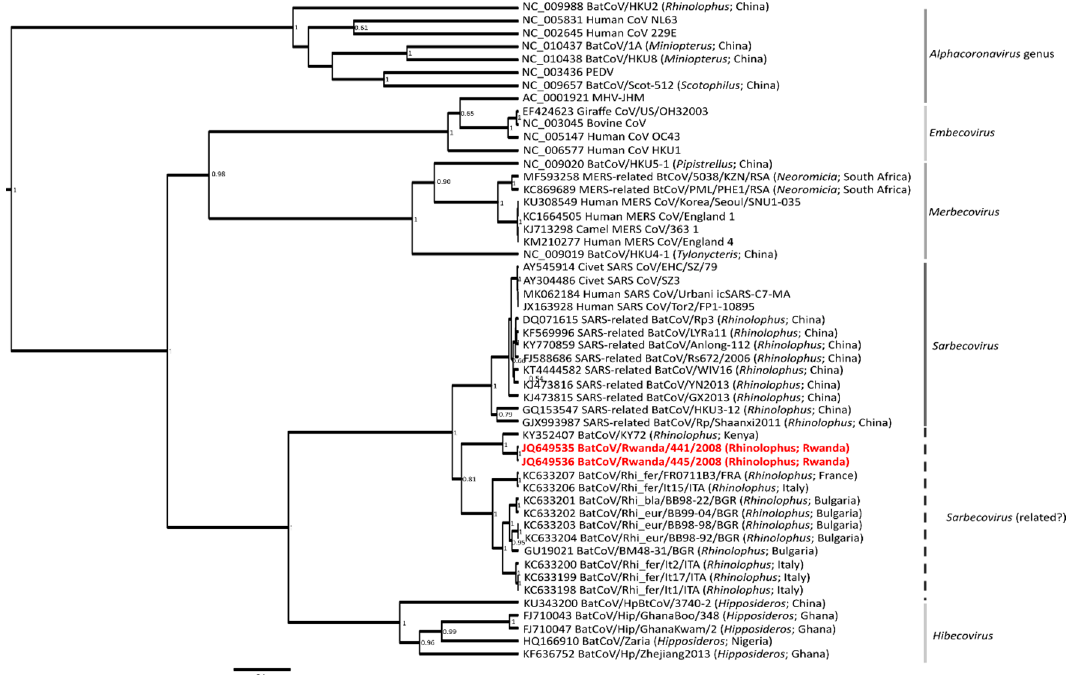
Figure 2. Bayesian phylogeny constructed based on a trimmed 780 bp sequence region of the RdRp gene of the coronavirus genome. The general time reversible model using gamma and invariant sites was determined using the jModelTest software version 2.1.6. The phylogeny was constructed using the BEAST version 1.8. Posterior probabilities of >0.5 are indicated at internal nodes. Subgenus and genus designations are indicated on the right, and sequences from this study are in red.